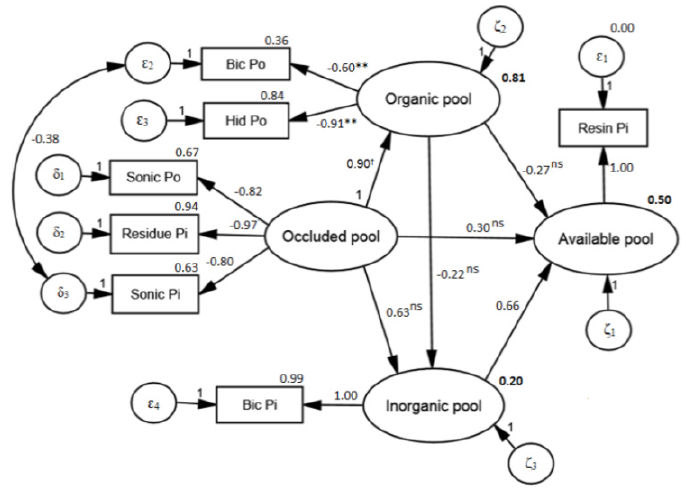
Figure 4. Structural equation modeling for the soil P cycle in Brazilian plantations. All measured variables (in boxes) are represented as effect indicators associated with latent variables (in circles). The numbers correspond to the standardized parameters estimated ( p < 0.001) and the R -squared values ( numbers in bold ). † Significant at p < 0.10, * at p < 0.05, ** at p < 0.01. Error variables ( ε 1 – ε 5 , δ 1 – δ 3 ) are standardized values. Model X 2 = 14.03, df = 9, p = 0.121.